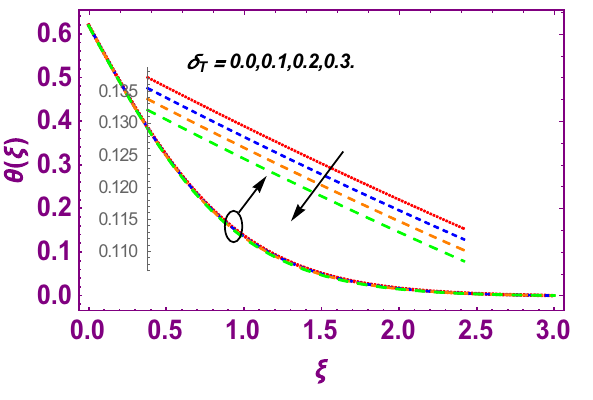
Figure 12. Effect of δ T on θ(ξ)